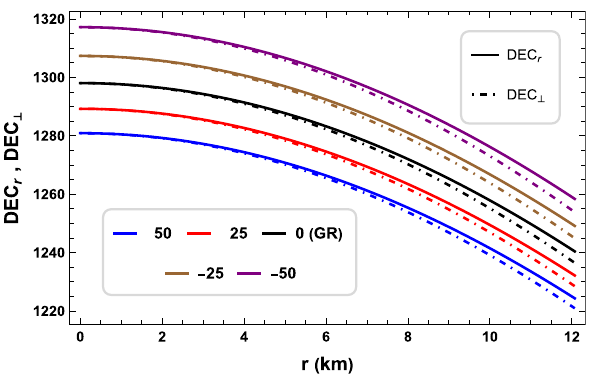
Fig. 15 DECagainstradialdistance r inPSRJ0348+0432fordifferent α values in 5D